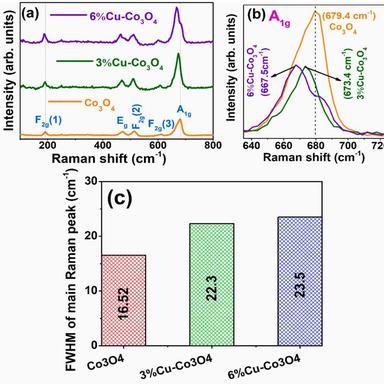
Comparison of Raman spectra (a), their magnified A1g Raman peaks (b), and FWHM of the A1g Raman peaks (c) of undoped Co3O4, 3%Cu–Co3O4, and 6%Cu–Co3O4.